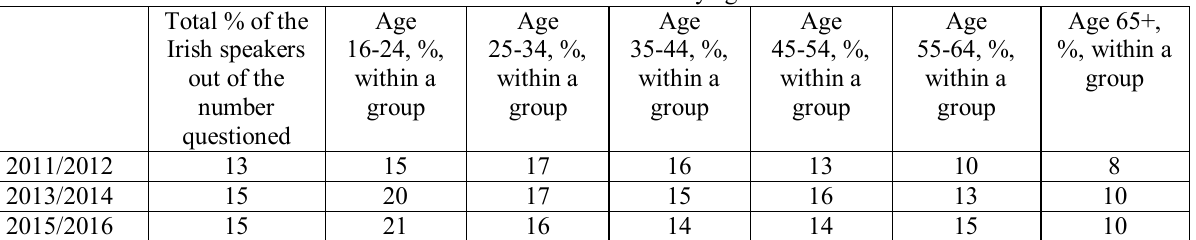
Table 3 – Irish skills by age.